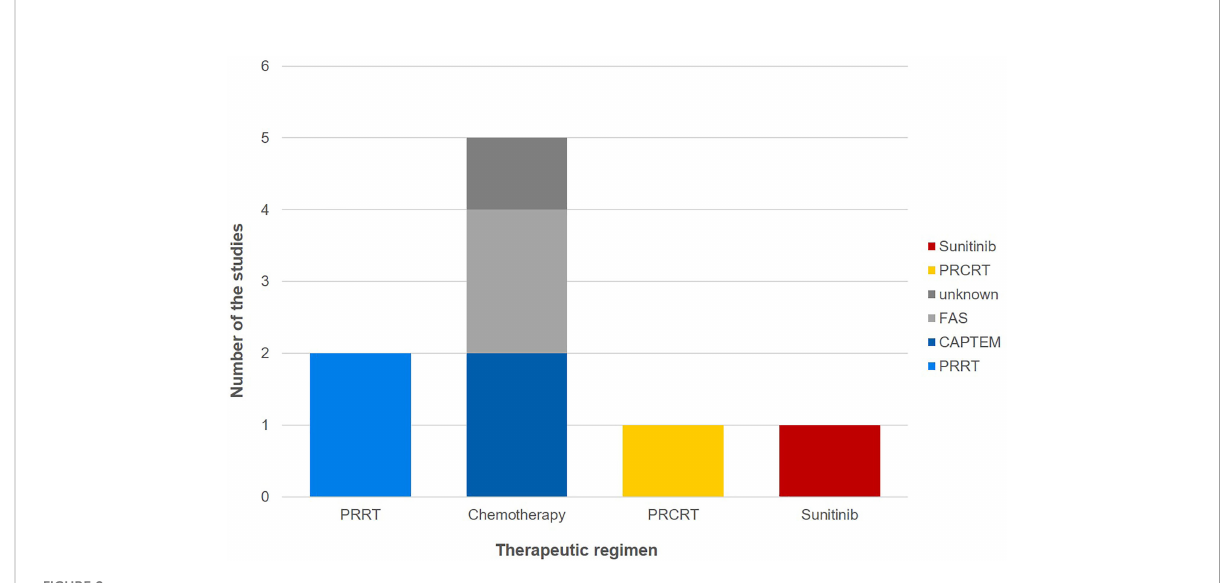
FIGURE 2 The number of studies of per neoadjuvant treatment regimen.